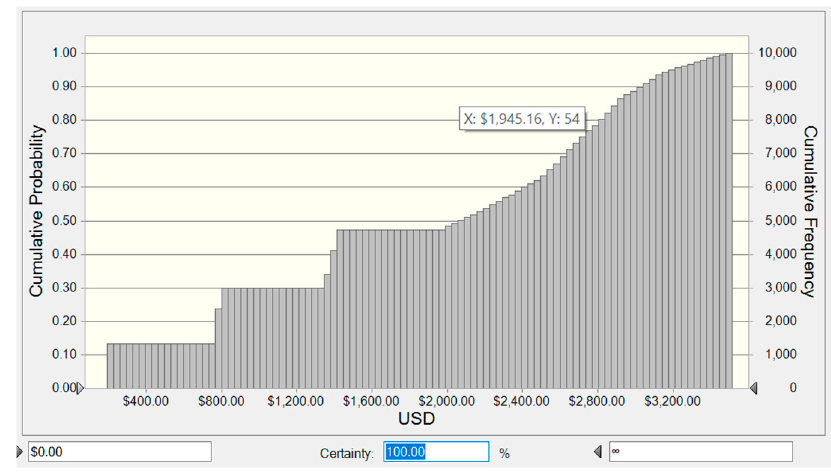
Figure 7. Stochastic results of NPV in the SE region.